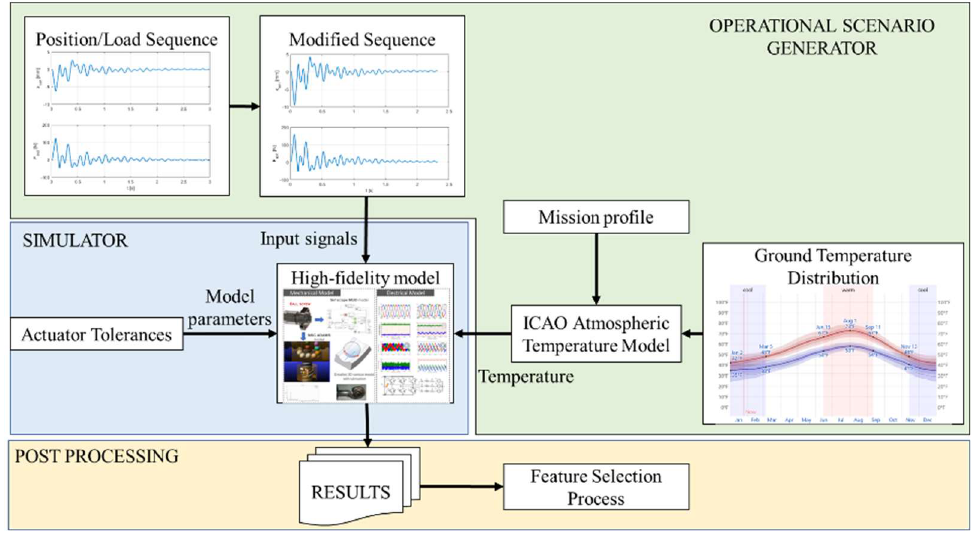
Figure 13. Data generation process to support PHM design.